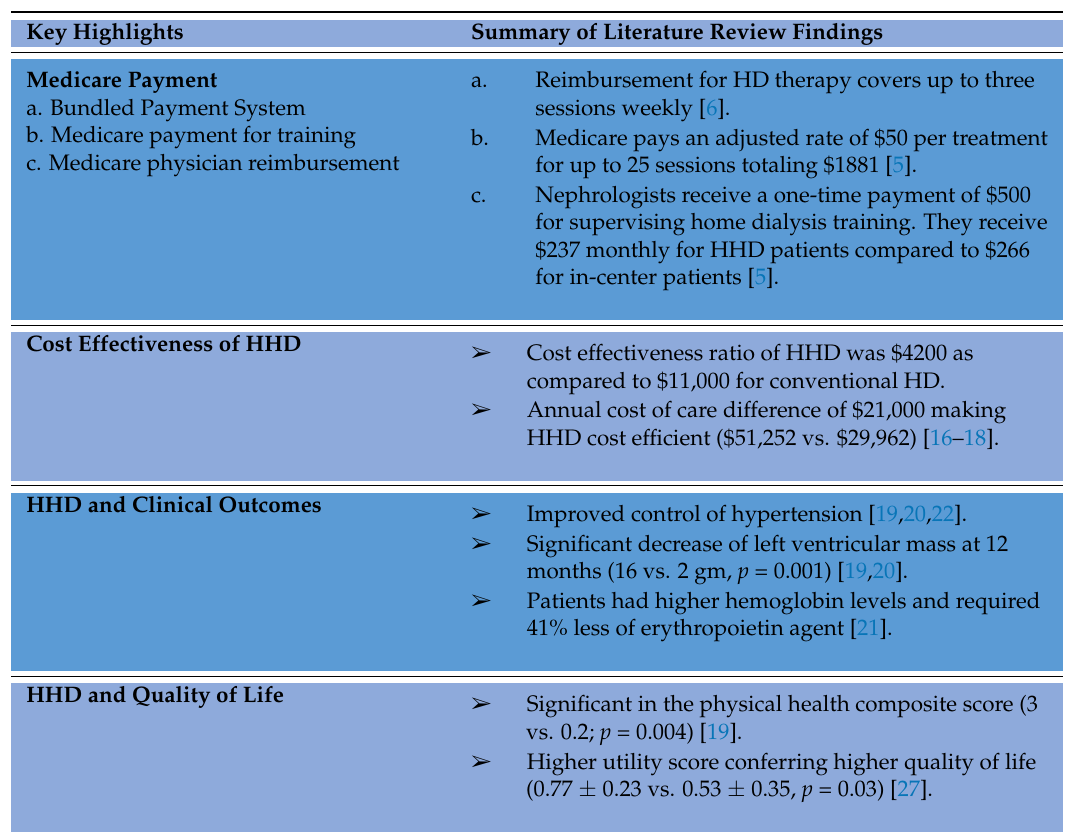
Table 1. Summary table of Literature Review